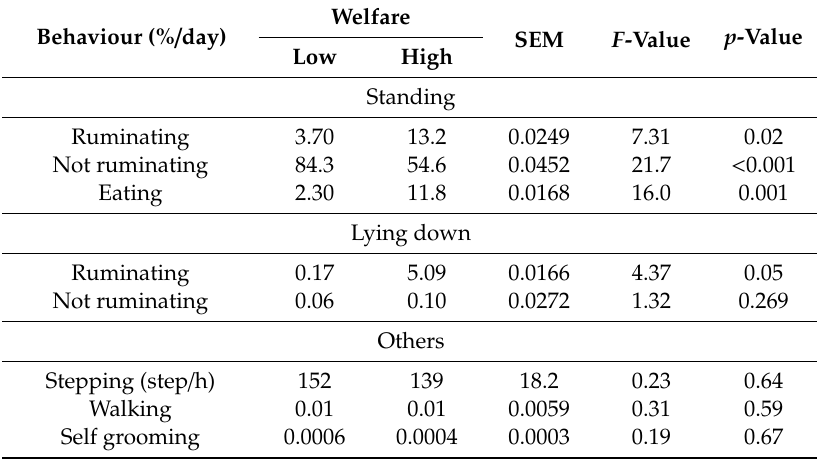
Table 5. E ff ects of Low and High welfare provision on behaviour responses of cattle during the transport by sea. Low 0.66 m 2 / head and High 0.86 m 2 / head.